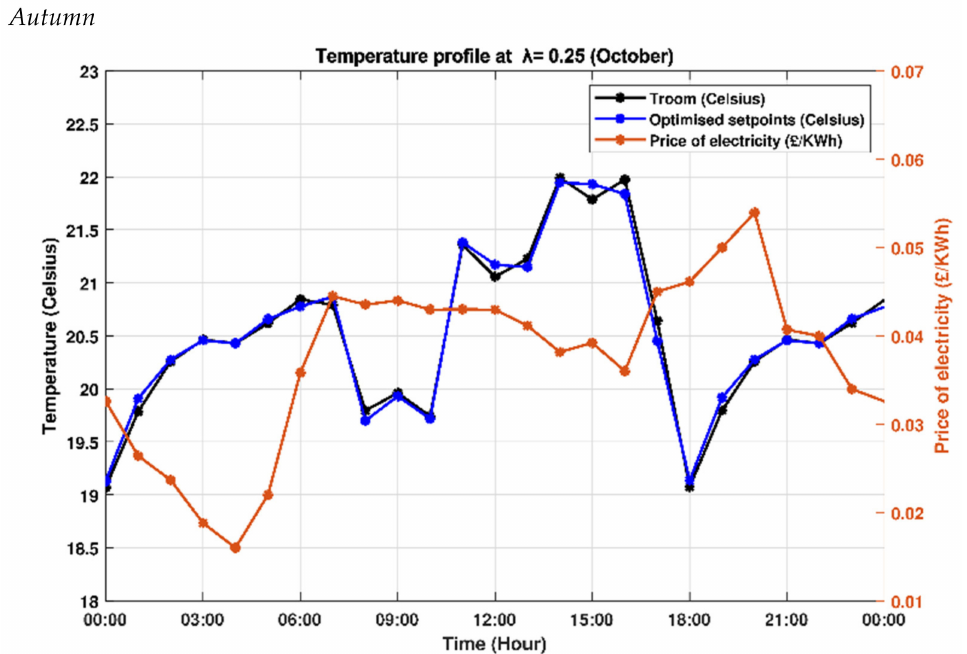
Figure 11. Room temperature and MPC-generated setpoints over 24 h using sample autumn season price